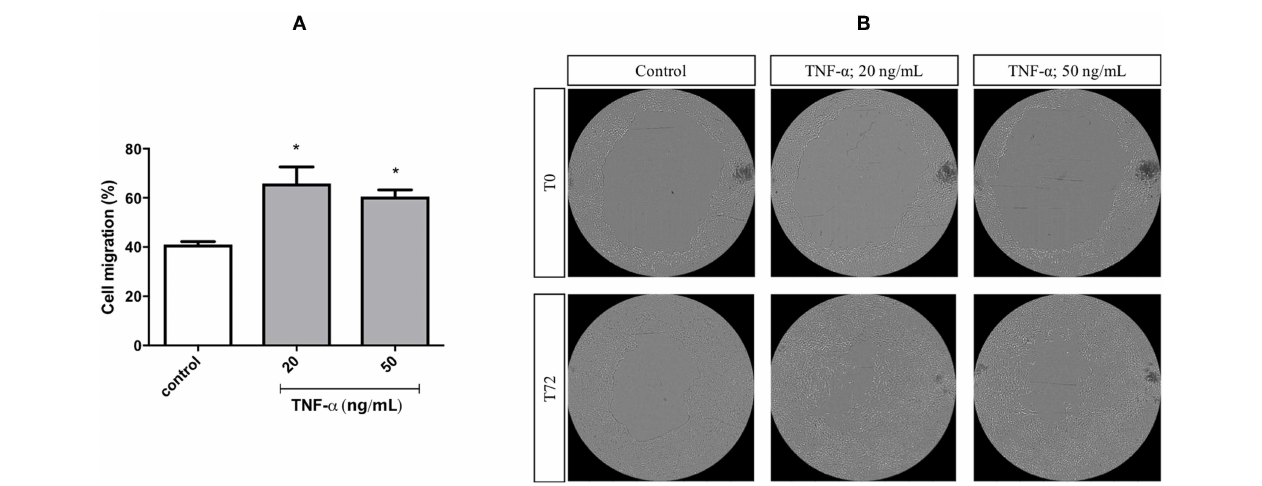
FIGURE 4 | Cell migration of FADU cells following stimulation with TNF- α . The FADU cell line was cultured for 24h in cell culture plates designed for migration assays, treated with mitomycin for 2h (to inhibit cell proliferation) and stimulated or not (Control) with TNF- α at 20 or 50ng/mL for 72h. Phase-contrast transmitted light images were acquired, with an ImageXpress Micro XLS HCS system (Molecular Devices), using a 4X objective. With aid of CellProfiler, cell migration was quantified based on the percentage of increase in the area occupied by cells. (A) Percentage of cell migration after 72h (Mean + -SD). (B) Representative images of different experimental conditions at initial time (T0) and after 72h (T72). Statistically significant differences (ONE-WAY Anova with Tukey post-test), in comparison to the control condition: * p <